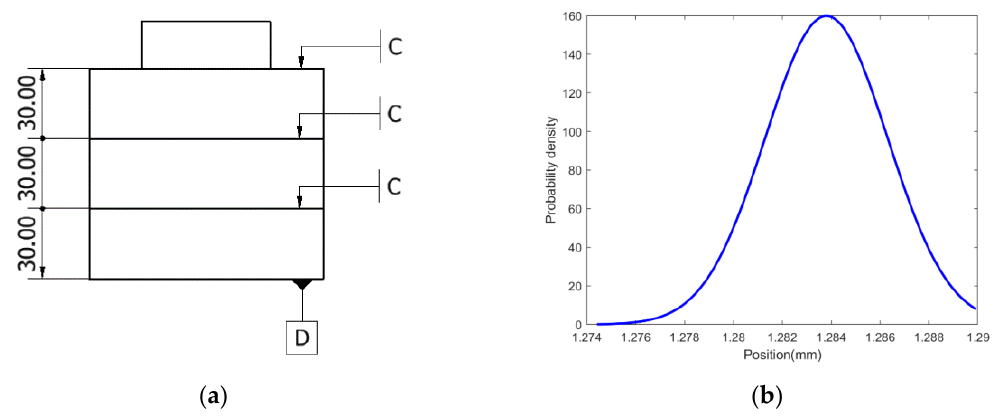
Figure 17. ( a ) A cylinder’s assembly; ( b ) result of statistical tolerance analysis based on observed data.